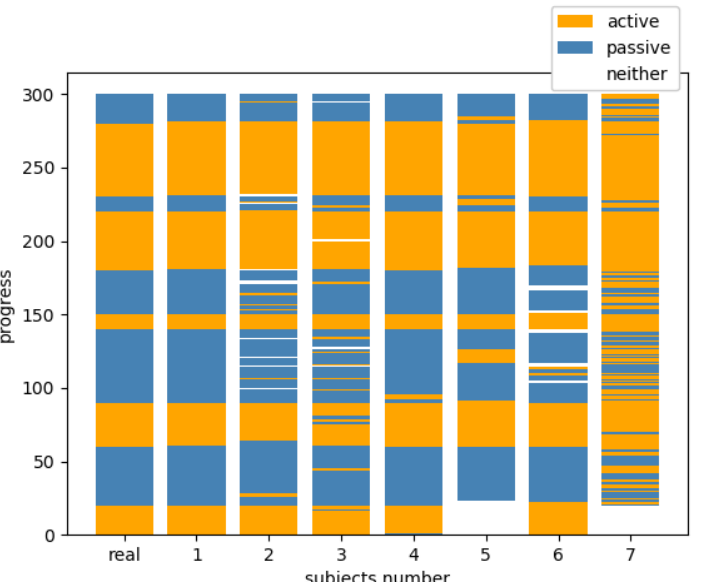
Figure 10. Computer agent’s strategy switching and subjects’ strategy estimation statuses in the second